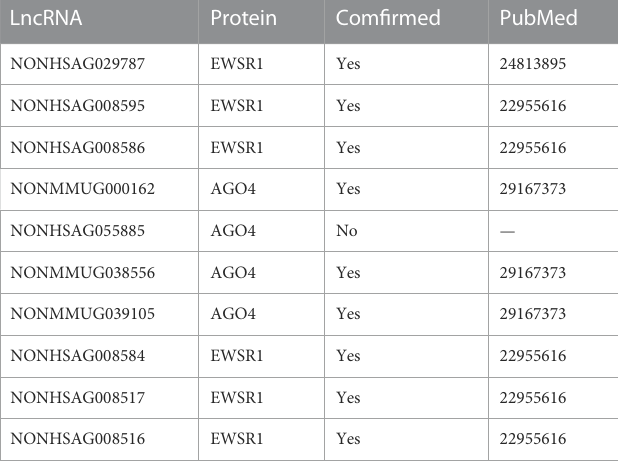
TABLE 6 Performance and standard deviation with four different learning rate. Datasets